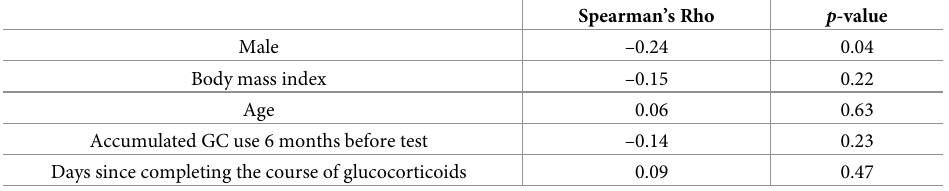
Abbreviations: GC,